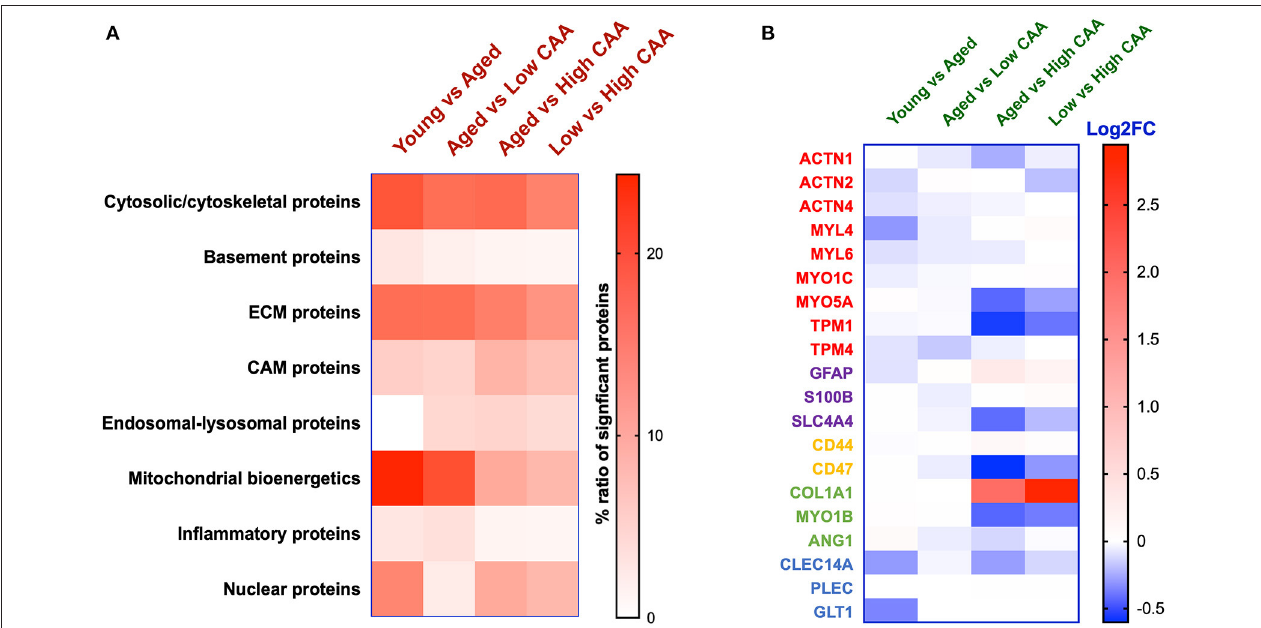
FIGURE 4 | Ratio of significantly regulated proteins per subcellular localization or biological function and Cell specific proteins expression levels identified in cerebrovasculature of young and aged controls, and AD cases staged by low vs. high CAA score. (A) Data shows percentage of significantly altered proteins associated with a biological function or subcellular localization. ECM—Extracellular matrix protein, CAM—cellular adhesion molecule. (B) Data shows cell specific proteins expression levels. Proteins in red represents smooth muscle cell markers, purple (astrocytes), yellow (microglia), pericytes (green), blue (endothelial cells). Data shows Log2 fold change ( note: not all cell specific proteins depicted passed the set cut-off value of P < 0.05 ).